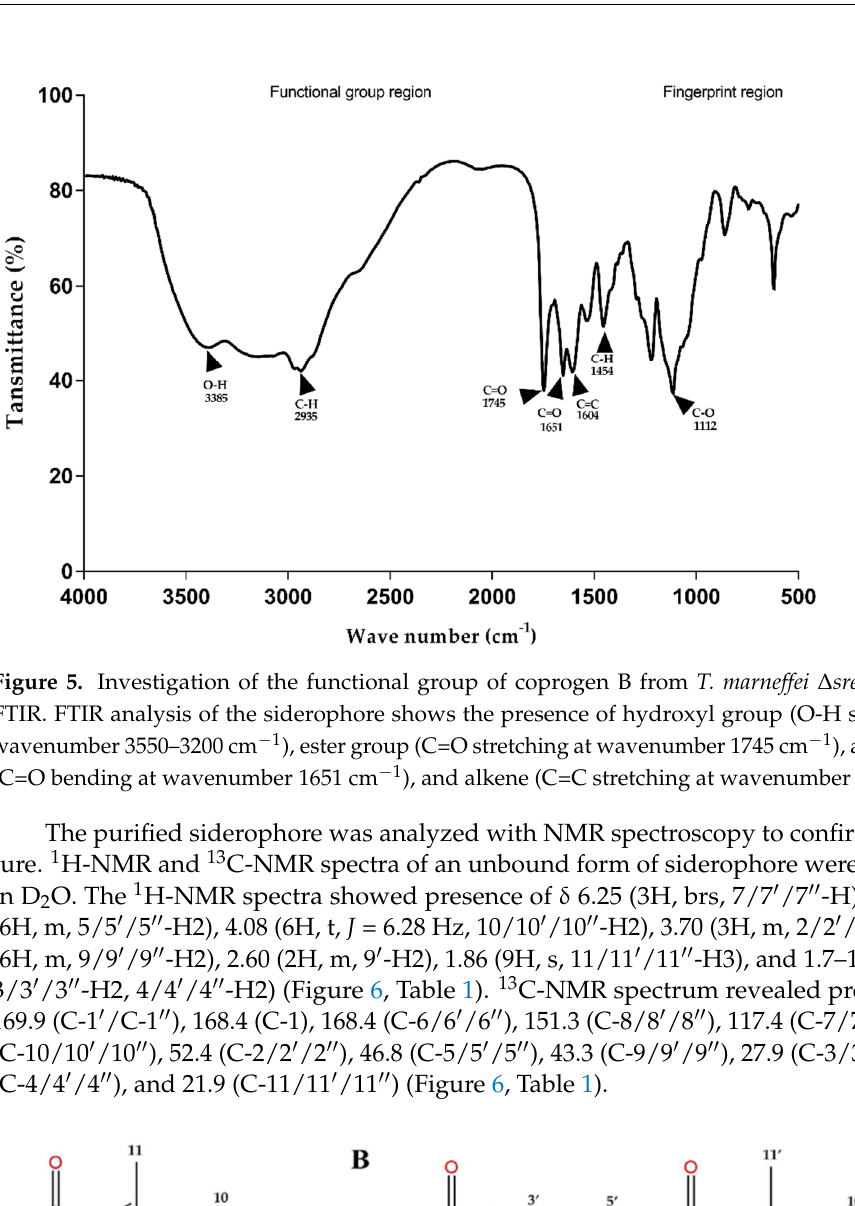
Figure 6. Three fragment structures of coprogen ( B ) are investigated by 1 H-NMR and 13 C-NMR spectroscopy. Fragment ( A ) is linked to fragment ( B ) via an ester group. Then, fragments ( B ) and ( C ) are linked through the amide group.